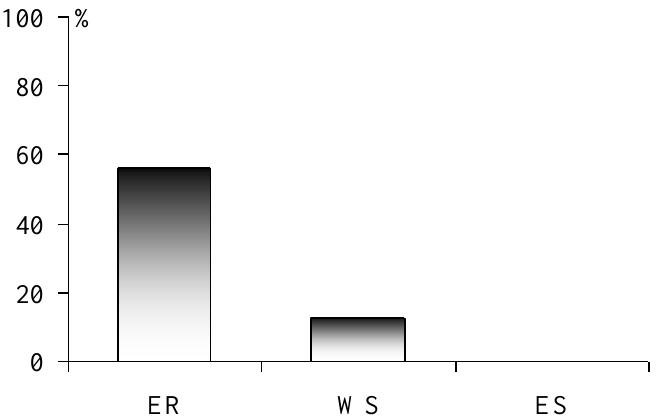
Figure 4. The percentage of lakes with critical loads exceeded in the Arctic regions of the European territory of Russia (ER), Western (WS) and Eastern Siberia (ES).